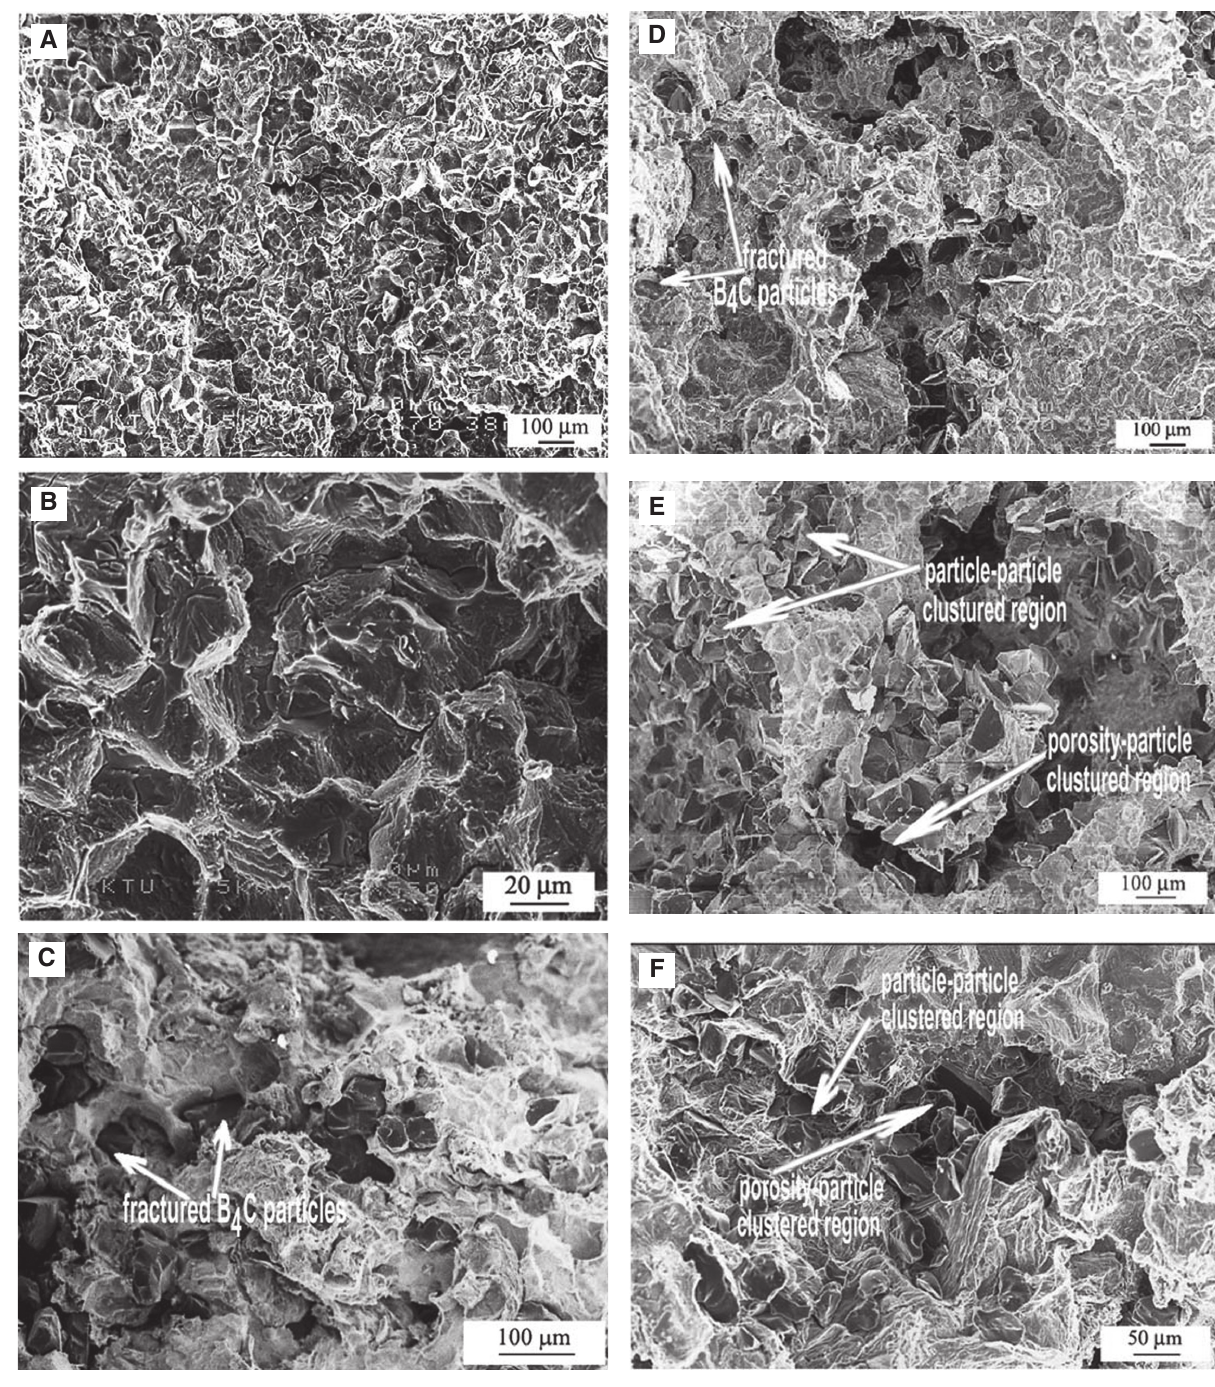
Figure 8 Representative SEMs showing fracture surface characteristics of different samples: (A) and (B) unreinforced AA2024 alloy, (C) C (fractured particle), (D) F (fractured particle), (E) C (clustered particle region), and (F) F 10 10